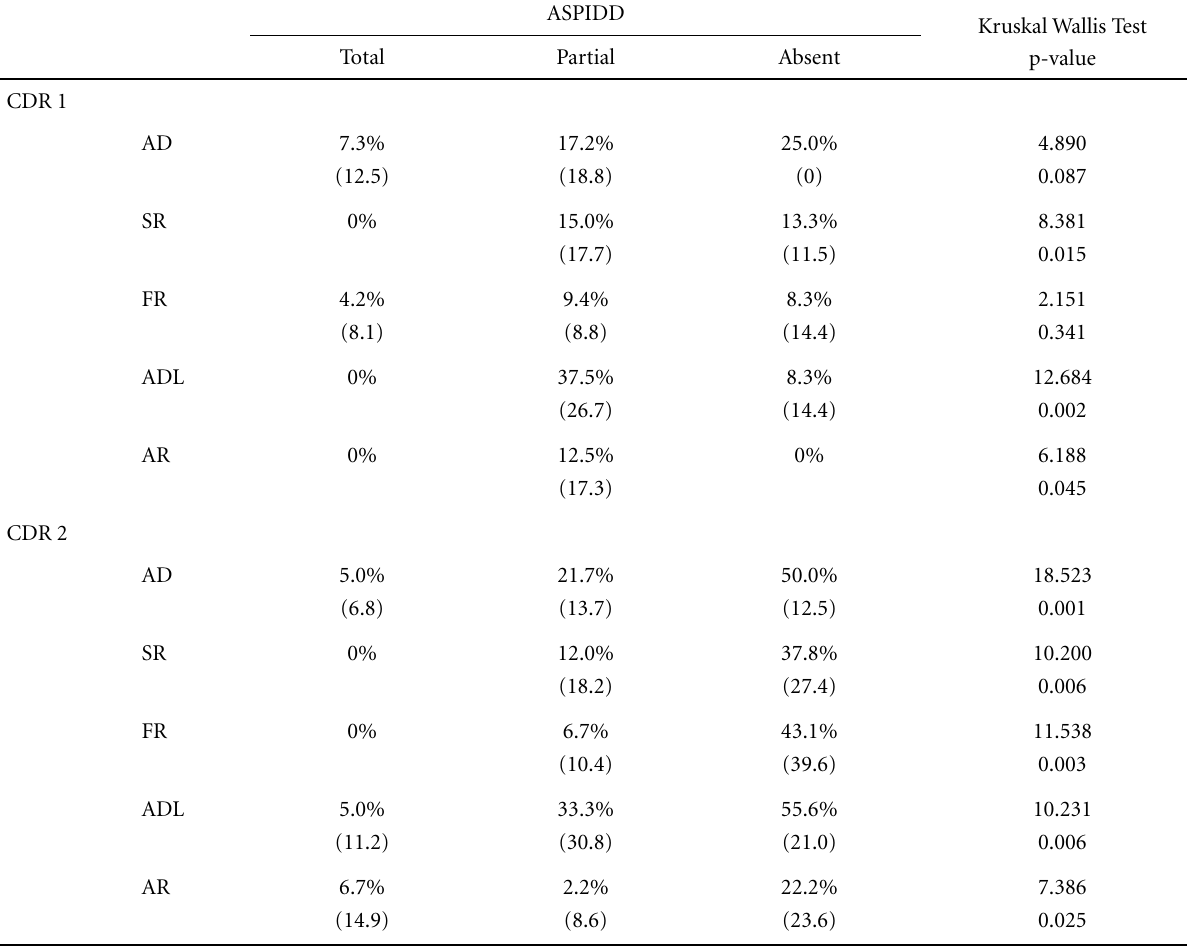
Table 2. Rate of discrepant patient-caregiver dyad responses in each ASPIDD* domain according to severity of dementia.